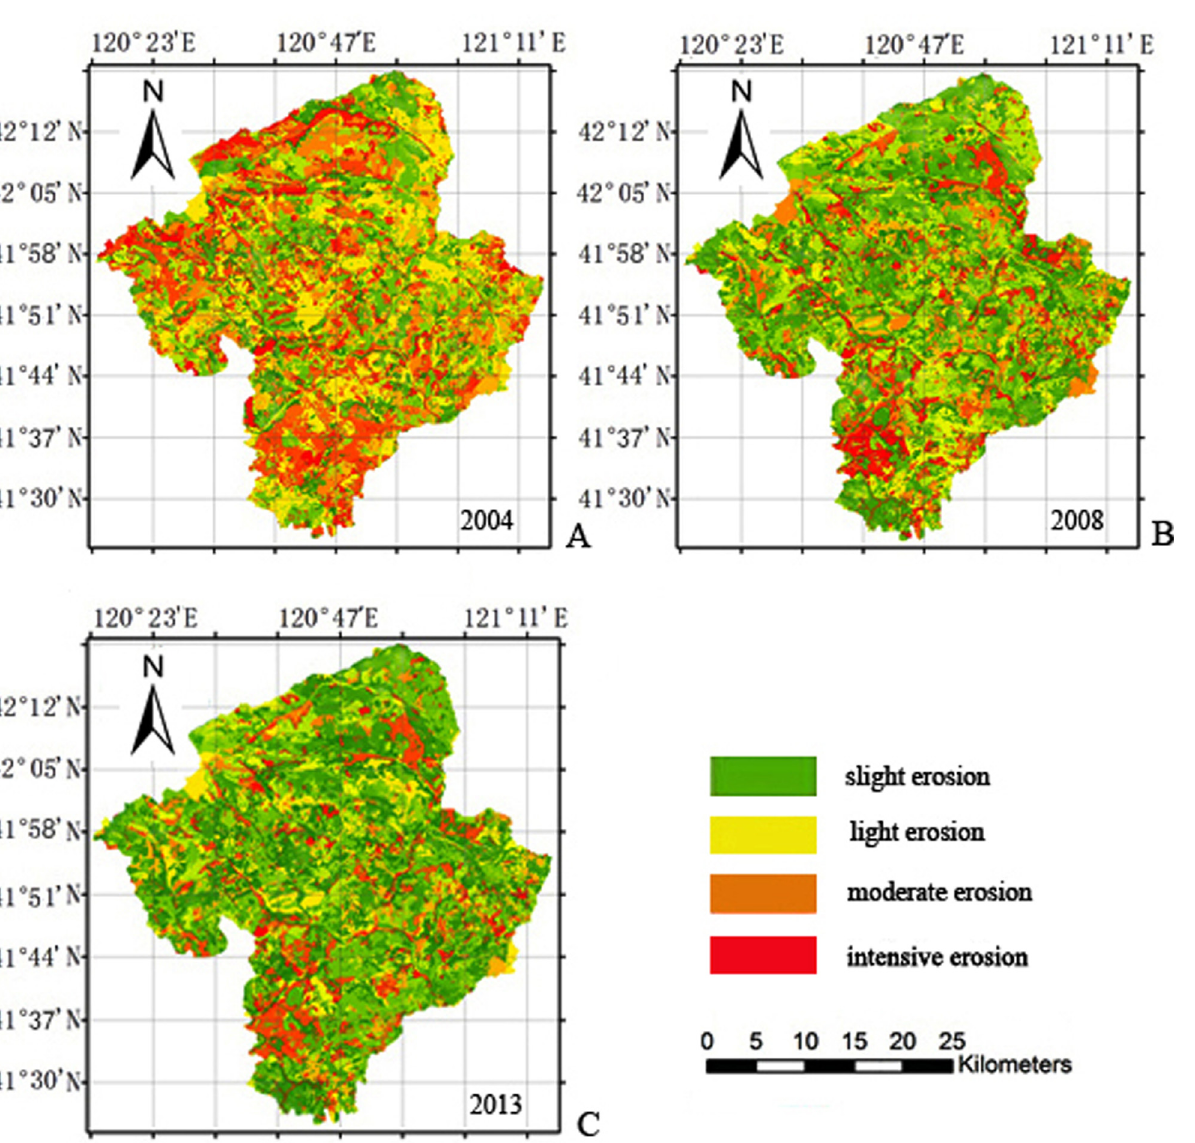
Fig 3. Soil erosion changes atlas in the Dahei Mountain ecological restoration area during different